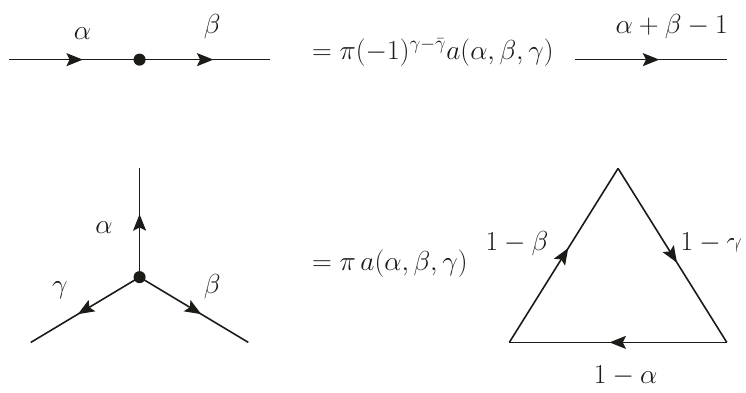
Figure 12 . The chain and star-triangle relations, (cid:11) + (cid:12) + (cid:13) = 2.